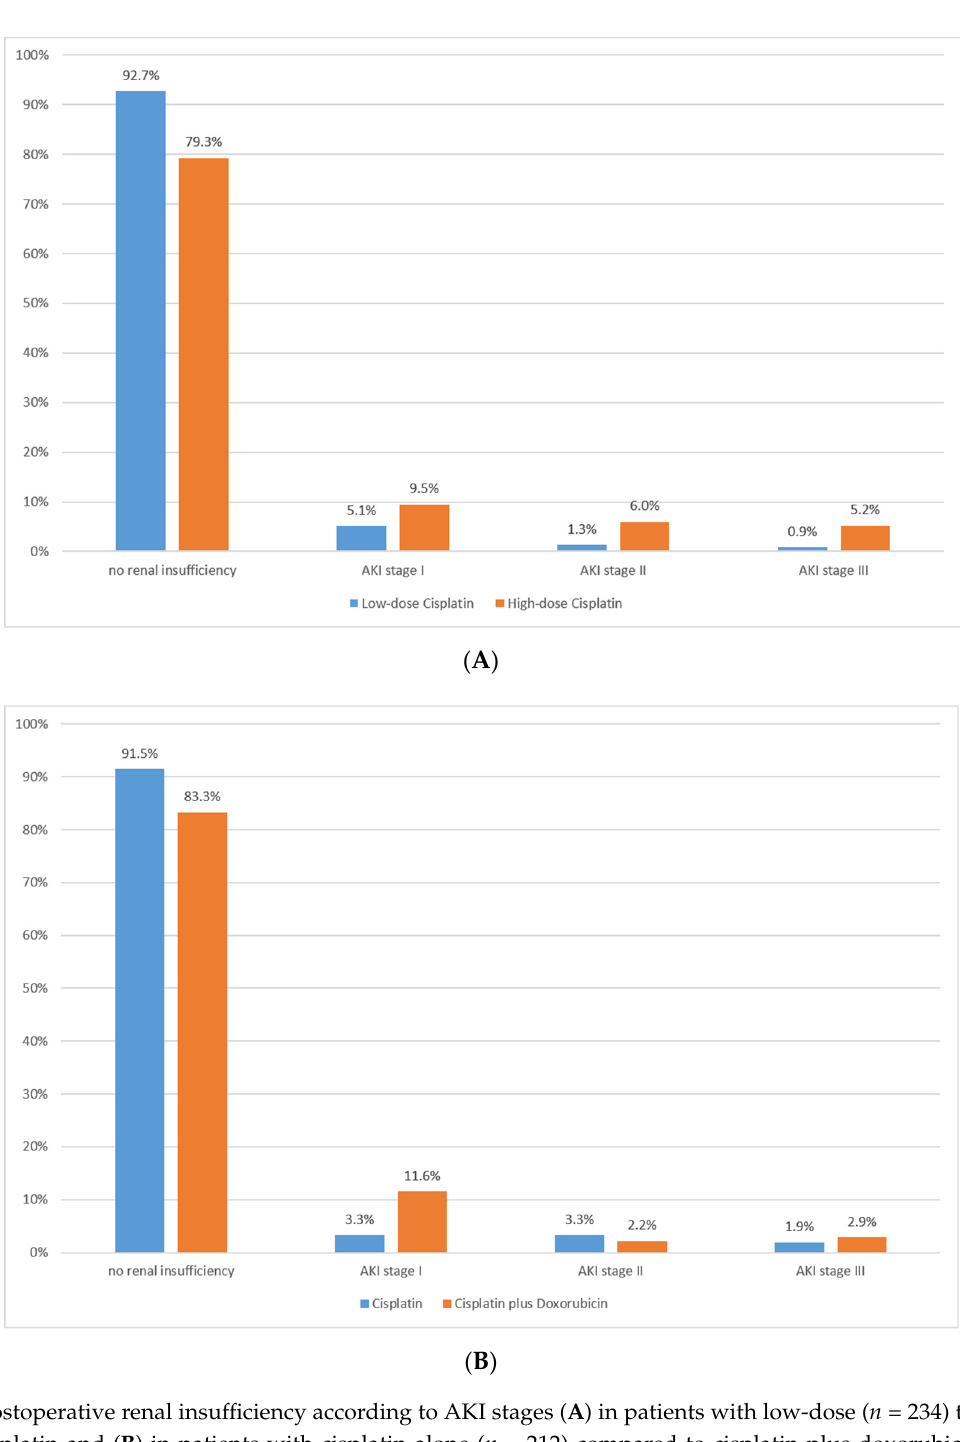
Figure 1. Postoperative renal insufficiency according to AKI stages ( A ) in patients with low-dose ( n = 234) to high-dose ( n = 116) cisplatin and ( B ) in patients with cisplatin alone ( n = 212) compared to cisplatin plus doxorubicin ( n = 138). AKI= acute kidney injury